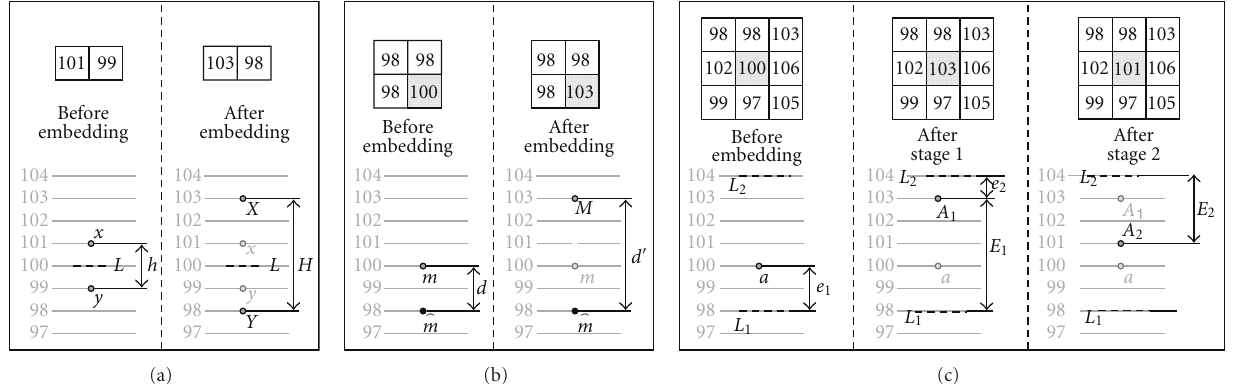
Figure 1: Di ff erent expansion strategies ((a) DE; (b) PEE; (c) Two-stage embedding).